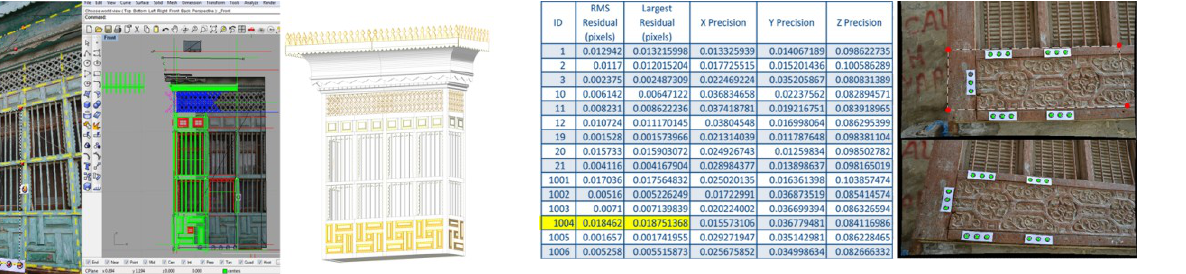
Figure 7. Modelling process in Rhinoceoros © software.